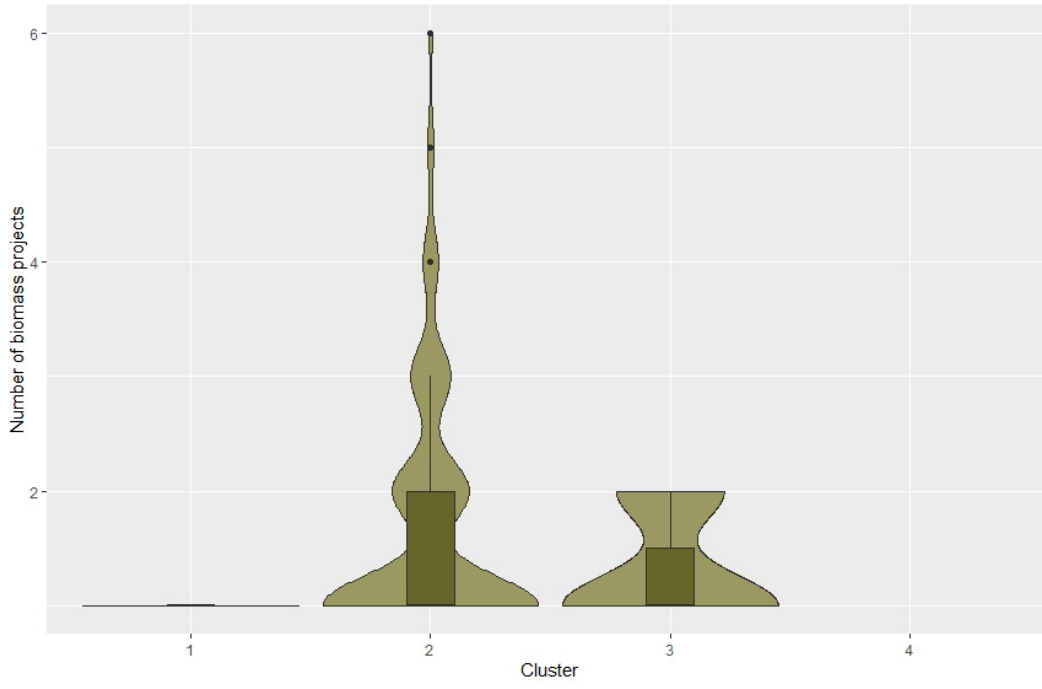
Figure A8. Violin plots for number of biomass projects in clusters, cluster 4–no projects.